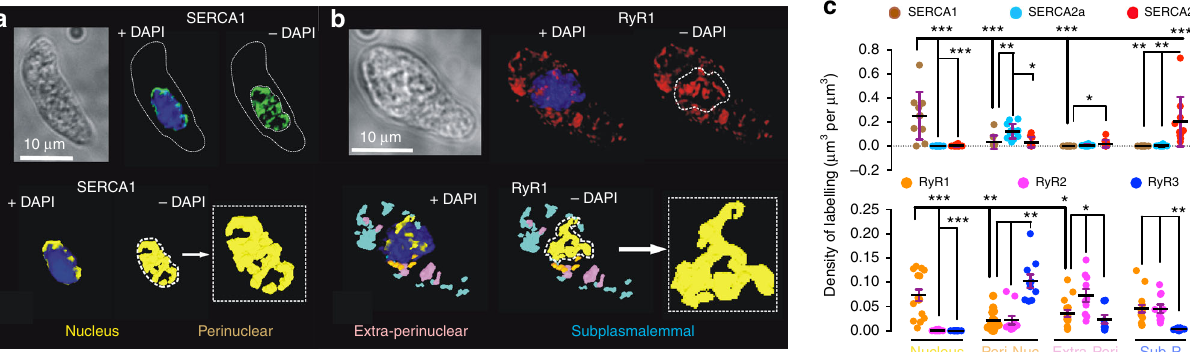
Fig. 1 Discrete clusters of SERCA1 and RyR1 are targeted to the nuclear envelope. a Upper panels, left to right, bright fi eld image of an arterial myocyte and 3D deconvolved fl uorescence images (Deltavision, doconvolution) of SERCA1 labelling (green). Lower panels, left to right, digital skin encapsulating SERCA1 labelling ± nuclear labelling (blue, DAPI). b As for ( a ) but for RyR1 labelling (red). c Dot plot shows density of labelling ( μ m 3 per μ m 3 , mean ± SEM) for (upper panels) SERCA1 ( n = 10 cells from 3 rats), SERCA2a ( n = 12 cells from 3 rats) and SERCA2b ( n = 10 cells from 3 rats) and (lower panels) RyR1 ( n = 15 cells from 3 rats), RyR2 ( n = 12 cells from 3 rats) and RyR3 ( n = 10 cells from 3 rats) within the 4 designated regions of the cell; one-way ANOVA followed by a Tukey post-hoc test: * p < 0.05, ** p < 0.01, *** p